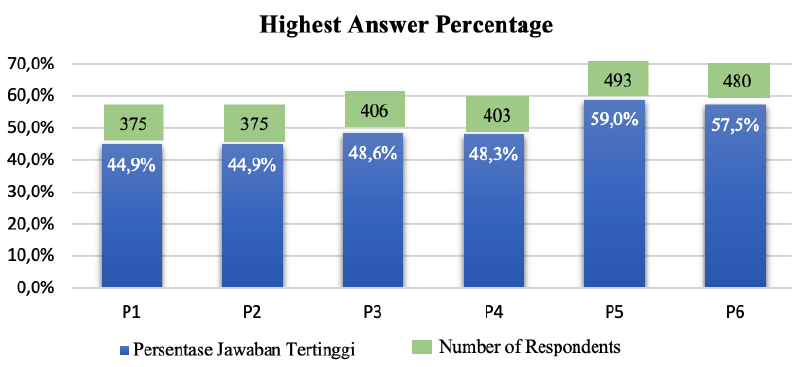
Figure 5: Percentage of Supporters for the Implementation of Career Service Programs by Students/Graduates